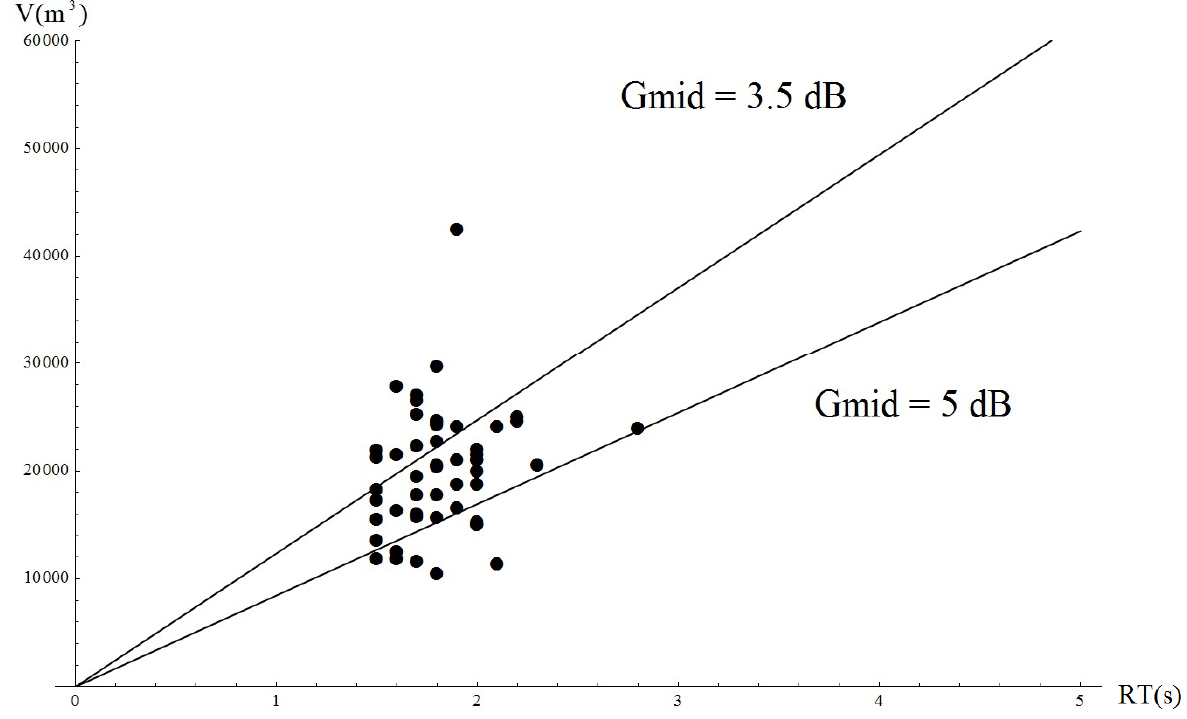
Figure 1. V-RT region following Beranek’s design procedure. Concert Halls from his 2006 book are shown